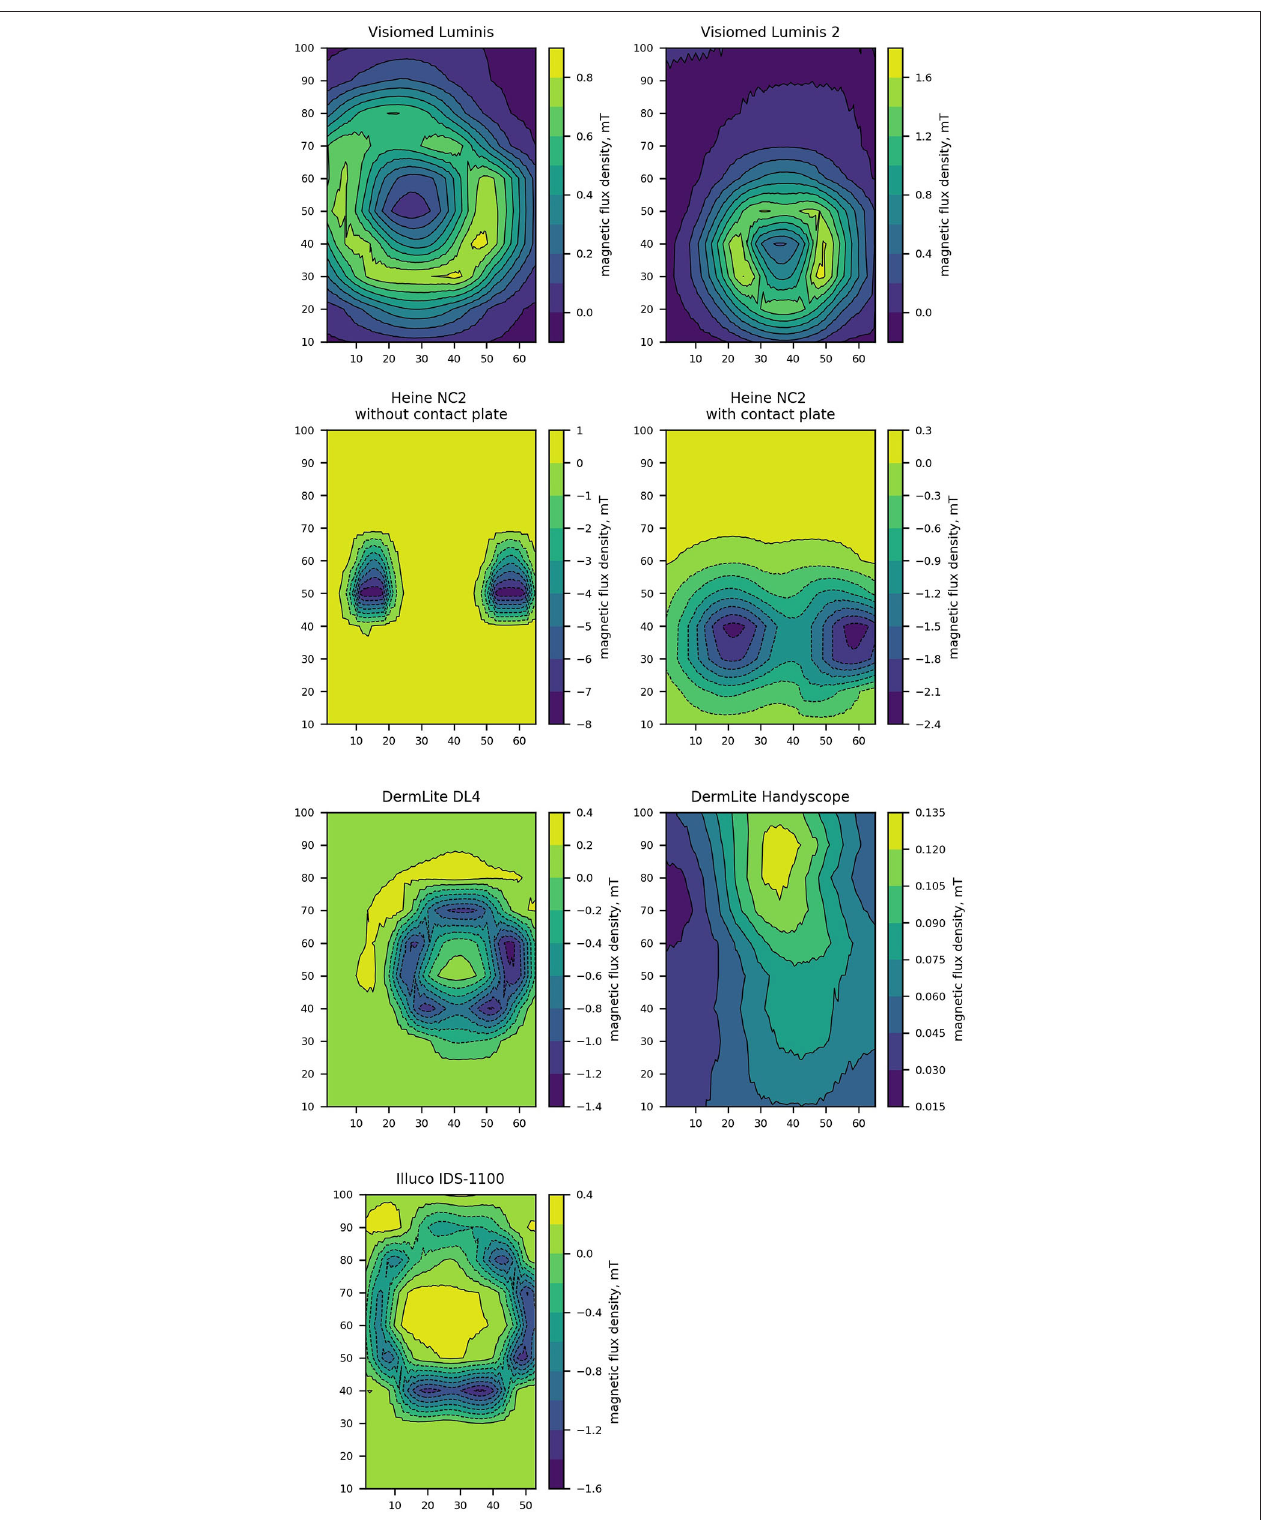
FIGURE 2 | Contour plots representing the perpendicular component of magnetic flux density measured directly over a dermoscope faceplate of the tested dermoscopes models. Dimensions of contour plots are expressed in milimeters.